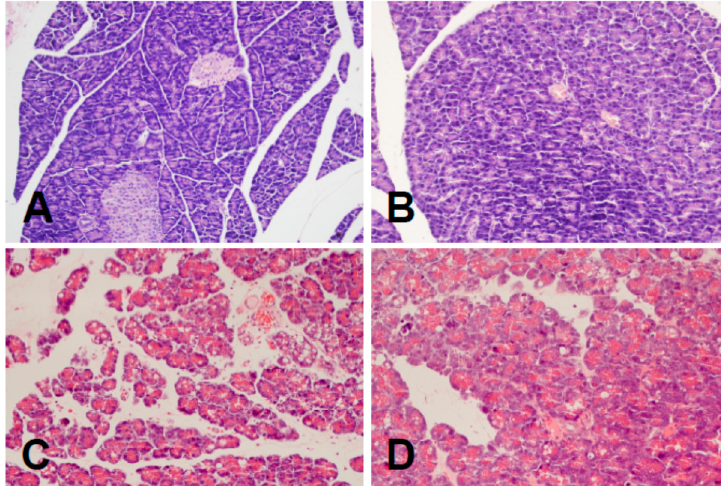
Figure 1. Representative morphological images of the pancreas observed in control rats treated with saline ( A ); rats pretreated with acenocoumarol at the dose of 50 µ g / kg / day without induction of acute pancreatitis ( B ); rats with cerulein-induced acute pancreatitis ( C ); rats pretreated with acenocoumarol (giventhedoseof50 µ g / kg / day)beforeinductionofacutepancreatitisbycerulein( D ).Hematoxylin-eosin counterstain, original magnification 200 ×